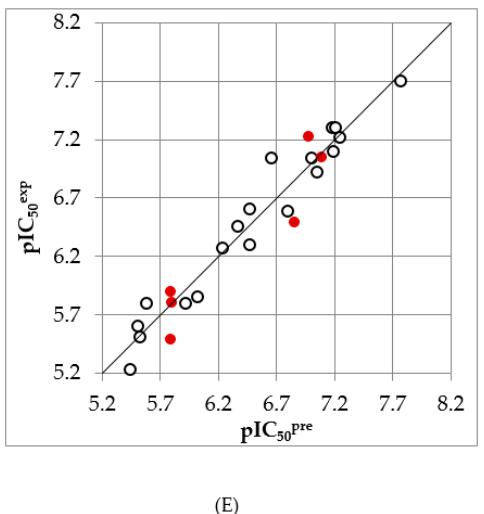
Figure 5. Features ( A ) coordinates of centers, ( B ) angles between centers of pharmacophoric features, ( C ) distances between centers, ( D ) mapping of pharmacophore of InhA inhibitor with the most potent molecule BHMB1. The R 1 position in the BHMBs of TS compounds is occupied by benzene ring (except BHMB8), therefore the second HYD expected from the InhA active site PH4 (Figure 1C) is replaced by Ar feature in BHMBs PH4. Feature legend: HYDA = Hydrophobic Aliphatic (blue), HYD = Hydrophobic (cyan), Ar = Ring aromatic (orange), HBA = Hydrogen bond Acceptor (green). ( E ) correlation plot of experimental vs. predicted inhibitory activity (open circles correspond to TS, red dots to VS).